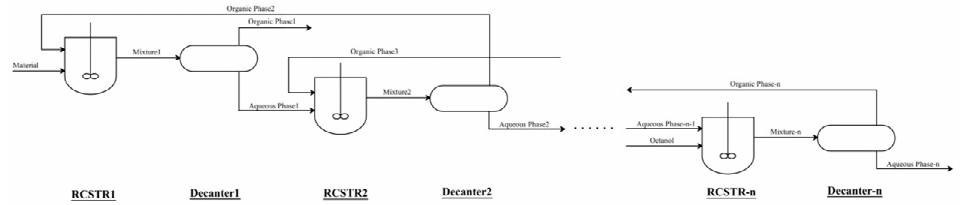
Figure 15. Multi-stage countercurrent reaction extraction simulation flow chart.